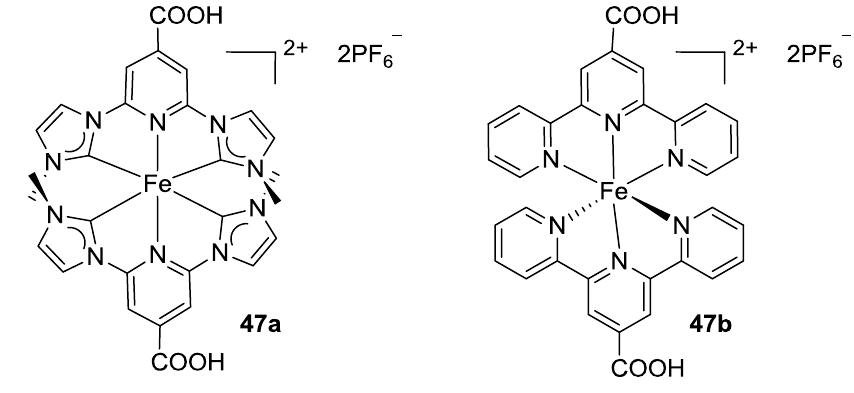
Figure 38. Iron complexes reported by Duchanois [152].